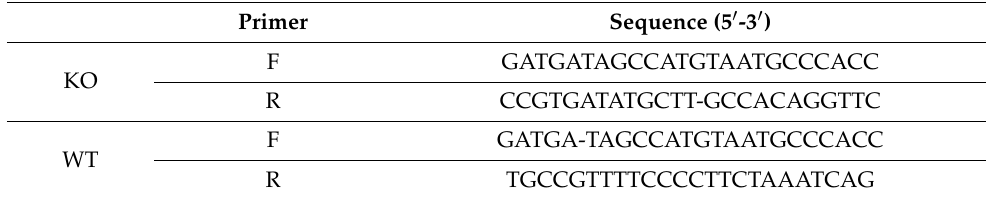
Table 1. The primers used for genotype identification.